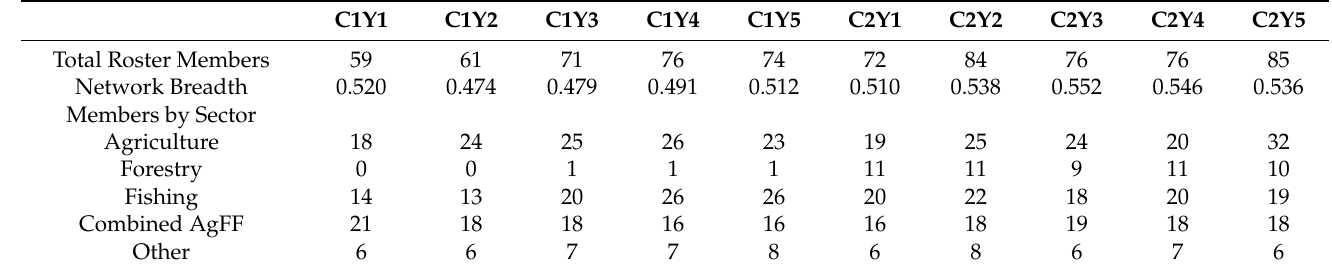
Table 2. Numbers of roster members by year and sector.